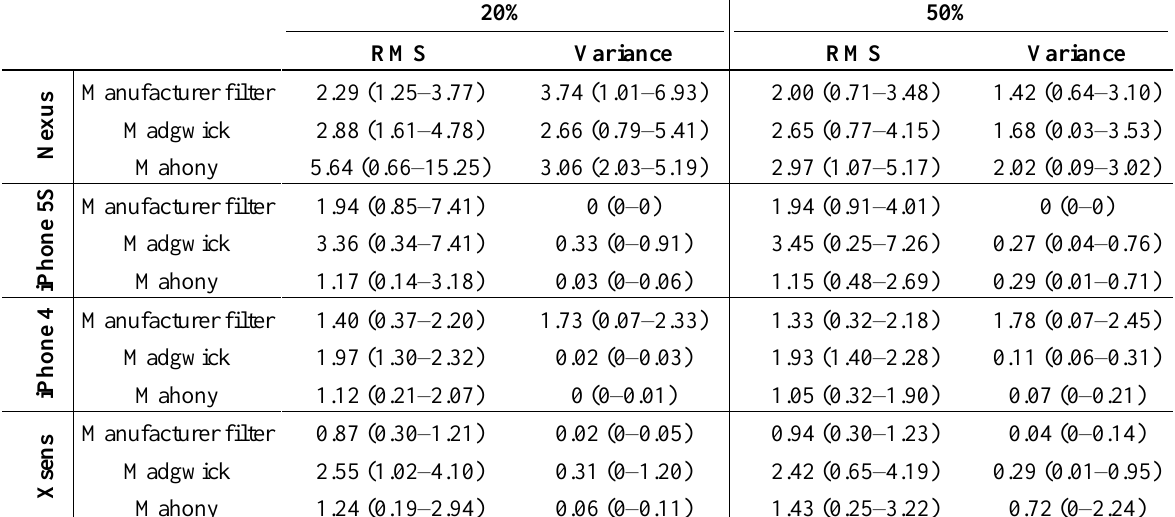
Table 5. Dynamic protocol results, mean (min–max), for pitch at rates of 20% and 50% of the maximum velocity in